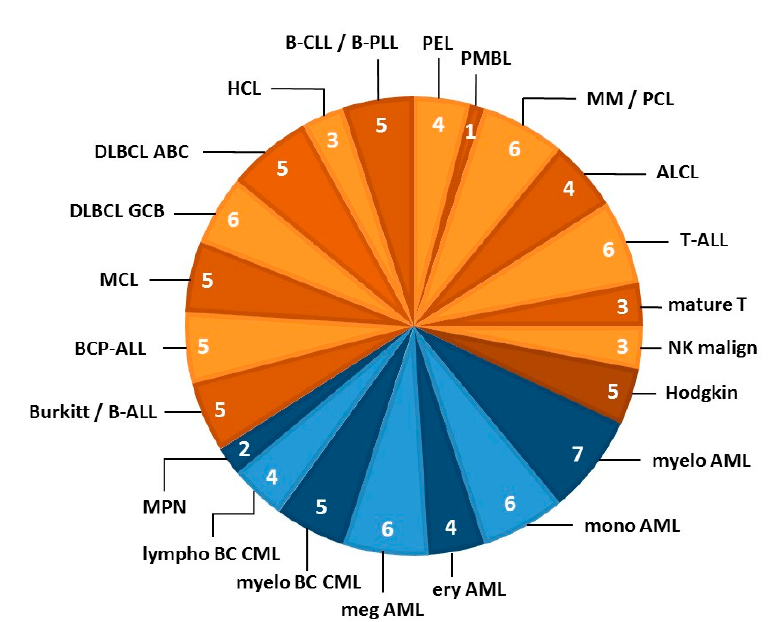
Figure 2. LL cell line stratification by disease category. The pie chart shows the 22 entities from which LL cell lines were derived that contributed to the LL-100 panel. Blue segments organized by entity represent myeloid malignancies and orange segments indicate lymphoid neoplasms (based on the revised WHO classifications of myeloid and lymphoid neoplasms; references [31,32]). The number of cell lines per entity is indicated in each segment. Each subset of LL cell lines was specifically tailored to represent this entity. The figure concept was further developed from Drexler et al. [33]. Abbreviations of disease entities: ABC, activated B-cell; ALCL, anaplastic large cell lymphoma; ALL, acute lymphoblastic leukemia; AML, acute myeloid leukemia; BC, blast crisis; BCP, B-cell precursor; CLL, chronic lymphocytic leukemia; CML, chronic myeloid leukemia; DLBCL, di ff use large B-cell lymphoma; ery, erythoid; GCB, germinal center B-cell; HCL, hairy cell leukemia; LL, lympbolastic lymphoma; lympho, lymphoid; malign, malignancy; MCL, mantle cell lymphoma; meg, megakaryocytic; myelo, myelocytic / myeloid; MM, multiple myeloma; mono, monocytic; MPN, myeloproliferative neoplasm; NK, natural killer; PCL, plasma cell leukemia; PEL, primary e ff usion lymphoma; PLL, prolymphocytic leukemia; PMBL, primary mediastinal B-cell lymphoma.